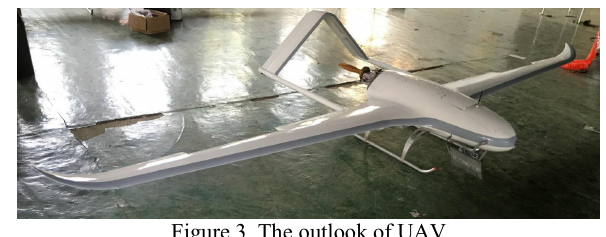
Figure 3 The outlook of UAV